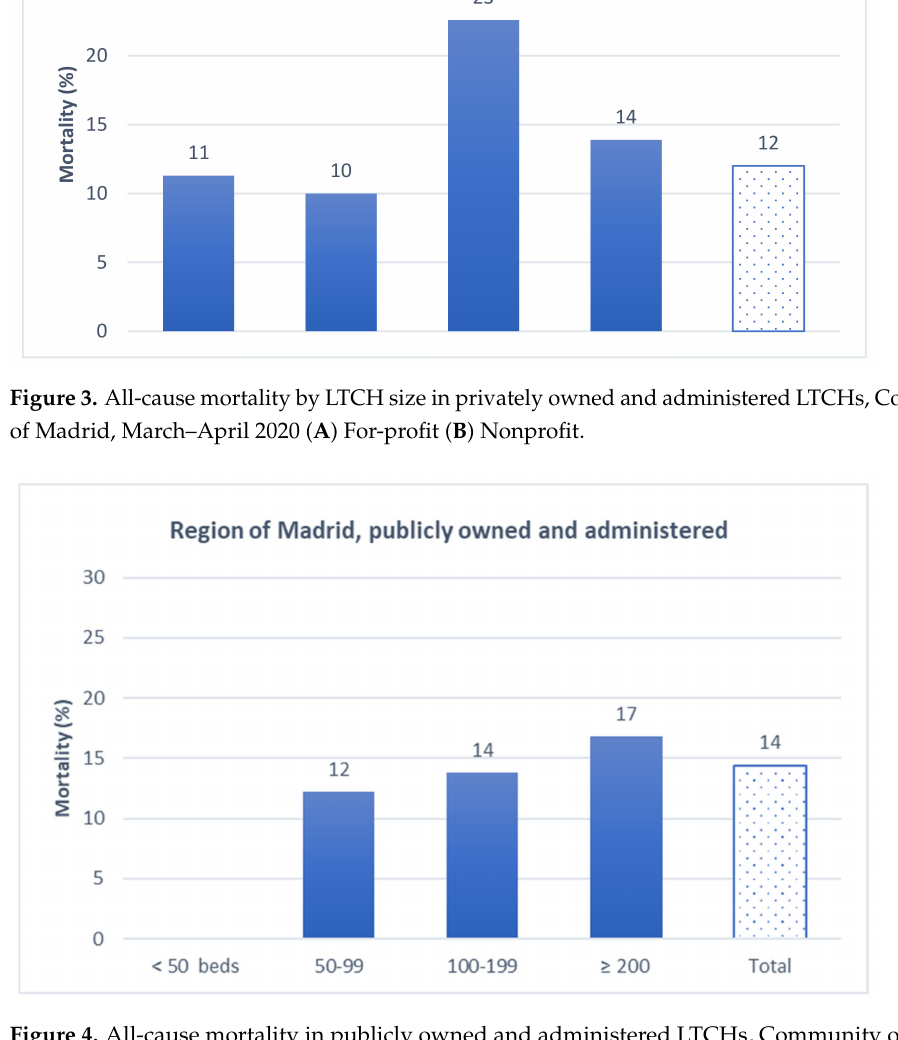
Figure 4. All-cause mortality in publicly owned and administered LTCHs, Community of Madrid, March–April